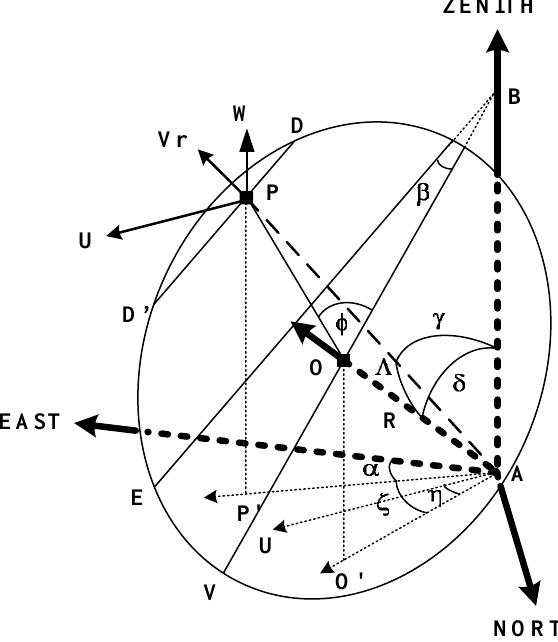
Fig. 9. Schematic configuration showing the geometric relations be- −→ AO of an oblique antenna beam tween coordinate, pointing vector with zenith angle δ , horizontal U and vertical W wind vectors, and the angular position of selected point P on the cross section of the oblique antenna beam pattern, where the coordinate of the point P is defined by cone angles 3 and azimuth angles φ with respect to the boresight of oblique antenna beam. For details of the other symbols in the plot, see